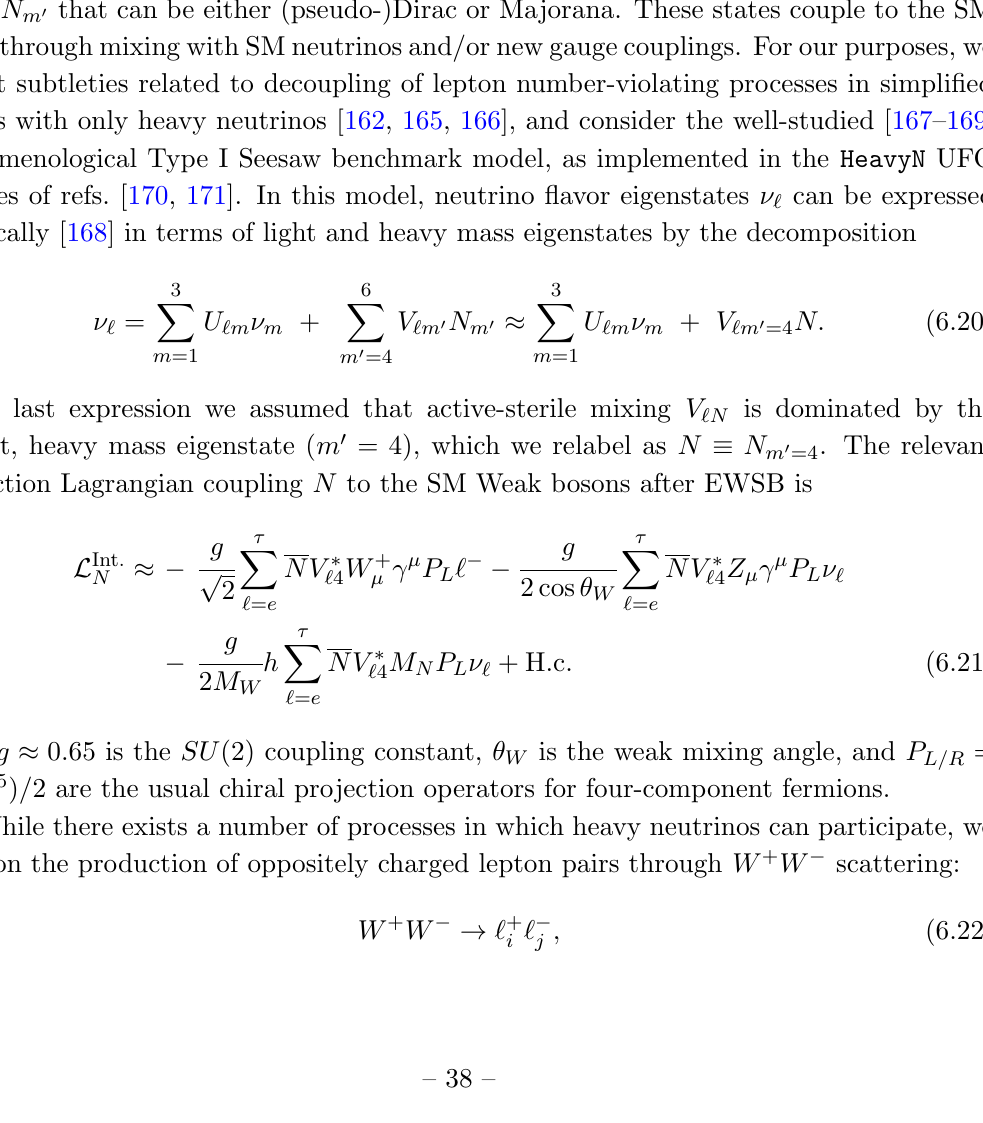
Figure 14 . (a) Diagrammatic representation of ‘ + neutrino N . (b) The cross section [fb] as a function of collider energy